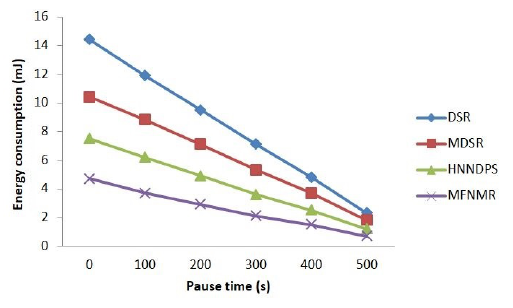
Figure 16. Energy Consumption Analysis based on Pause Time.